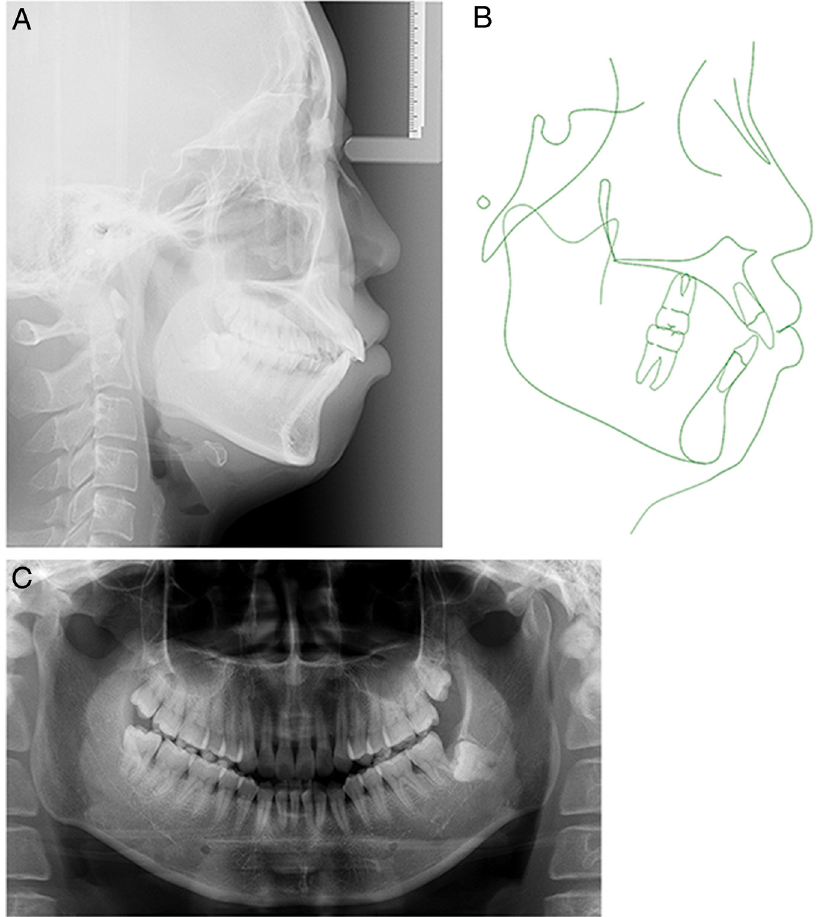
Figure 3. Pretreatment radiographs and tracing: (A) lateral cephalometric radiograph; (B) cephalometric tracing; and (C) panoramic